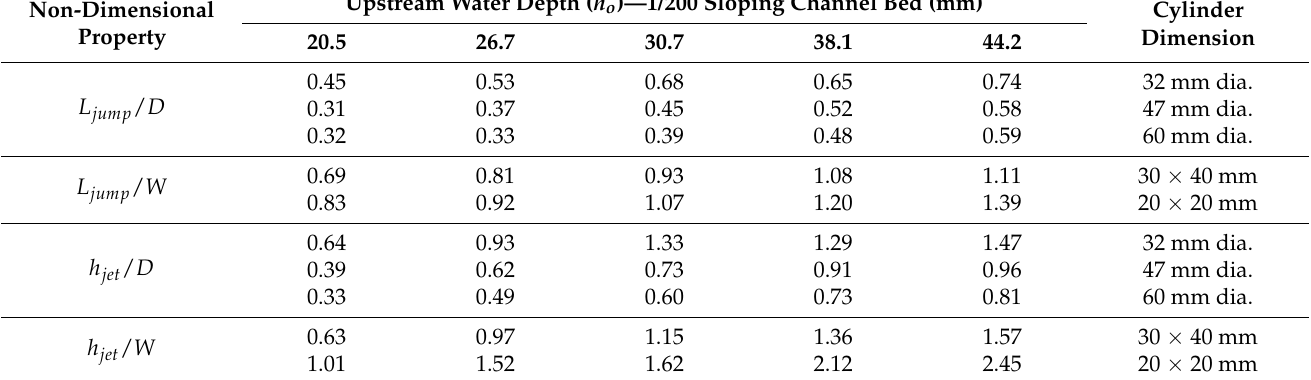
Table 4. Non-dimensional hydraulic jump detachment length ( L ∗ bow-wave height ( h ∗ ) relative to the geometry for case C1 for the supercritical flow when the channel jet bed slope equaled 1/200.